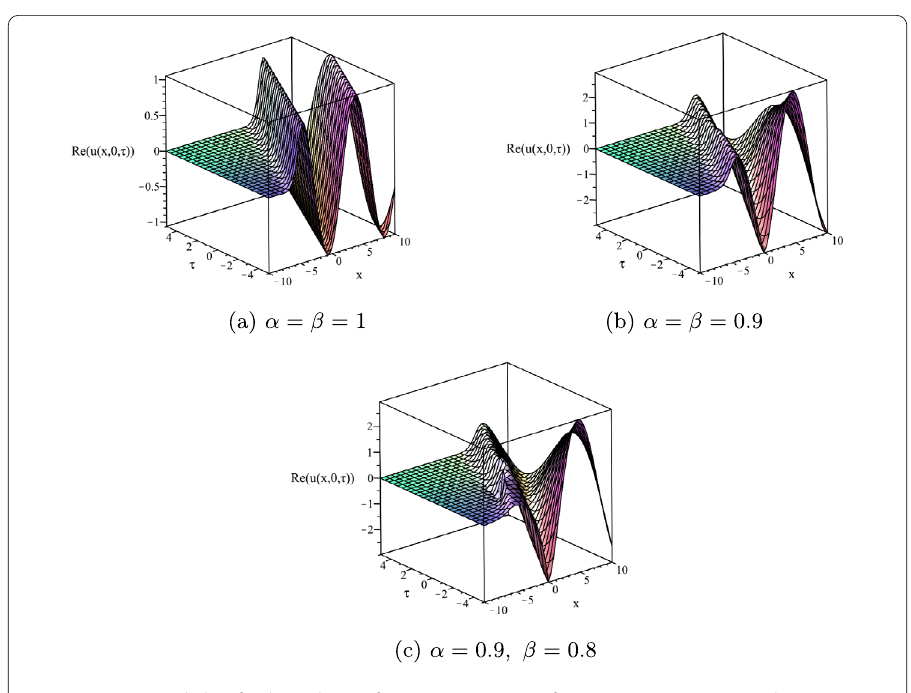
Figure 1 Associated plots for the real part of u 2 ( x , z , τ ) in Eq. (45) of Eq. (1) on –10 ≤ x ≤ 10 and –5 ≤ τ ≤ 5 using the modified Kudryashov